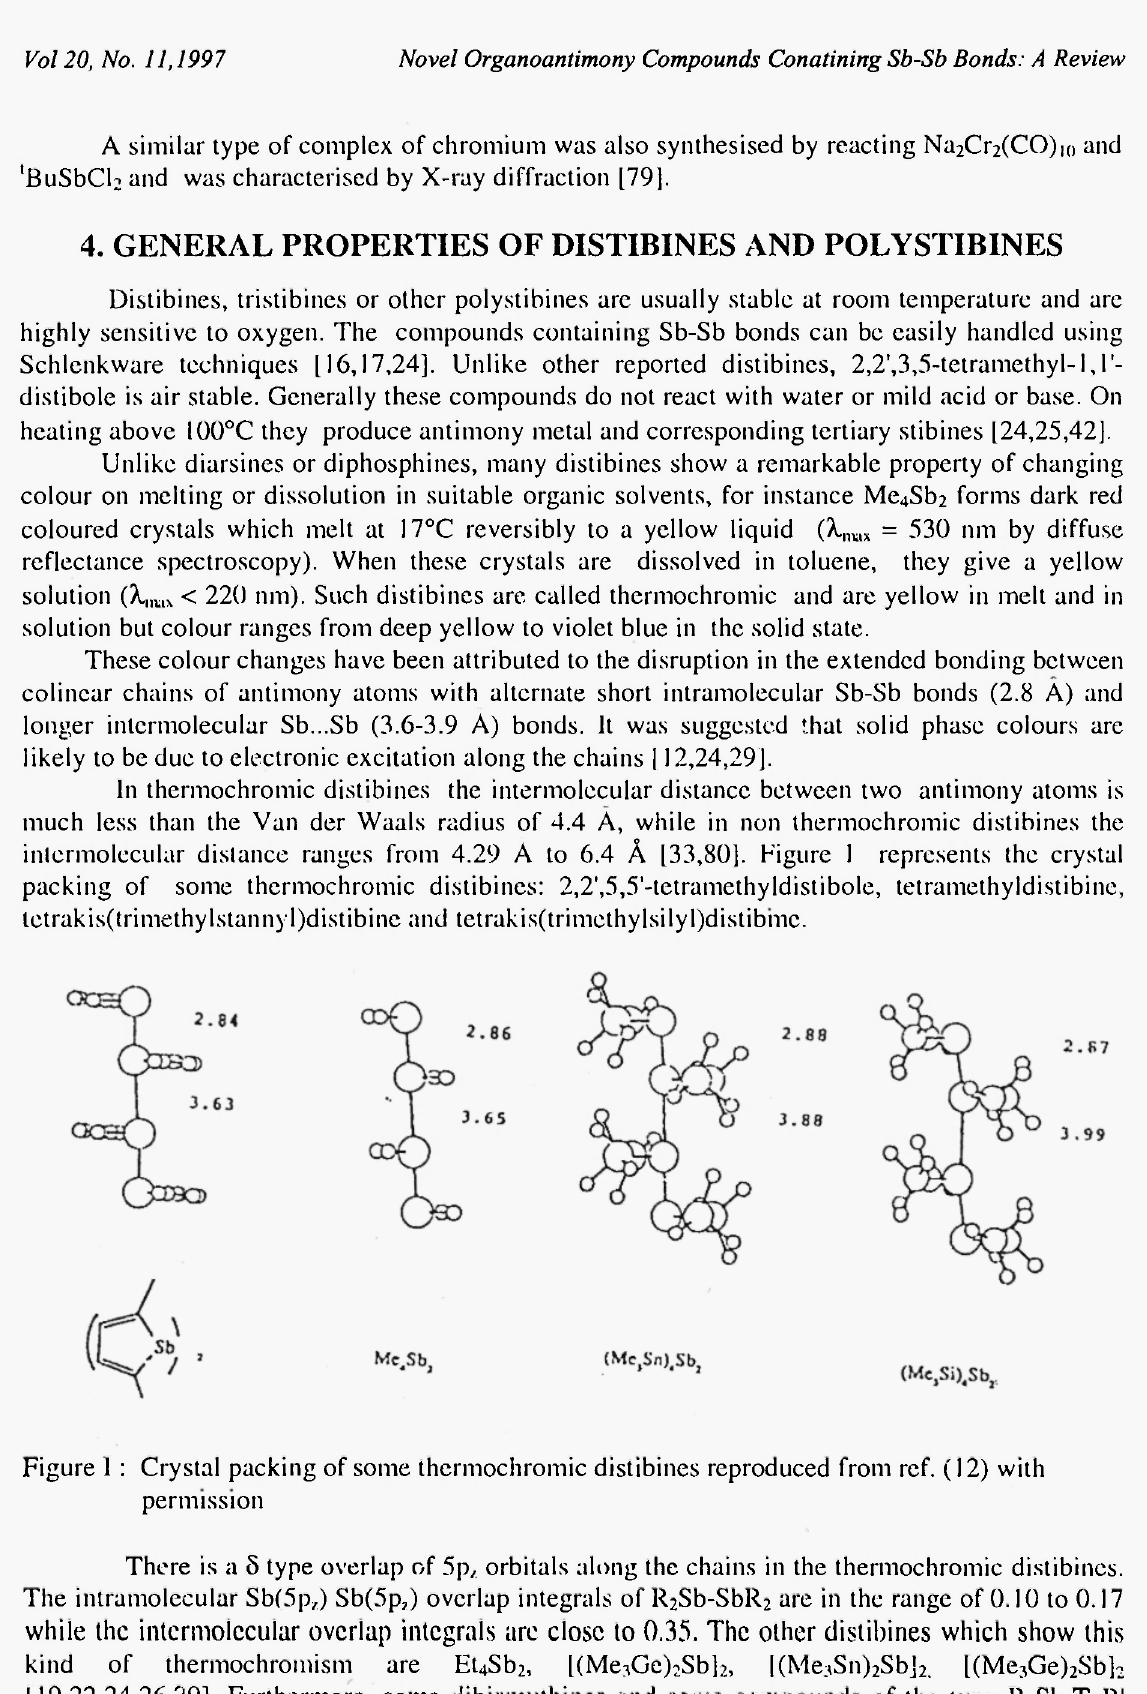
Figure I: Crystal packing of some thermochromic distibines reproduced from ref. (12)